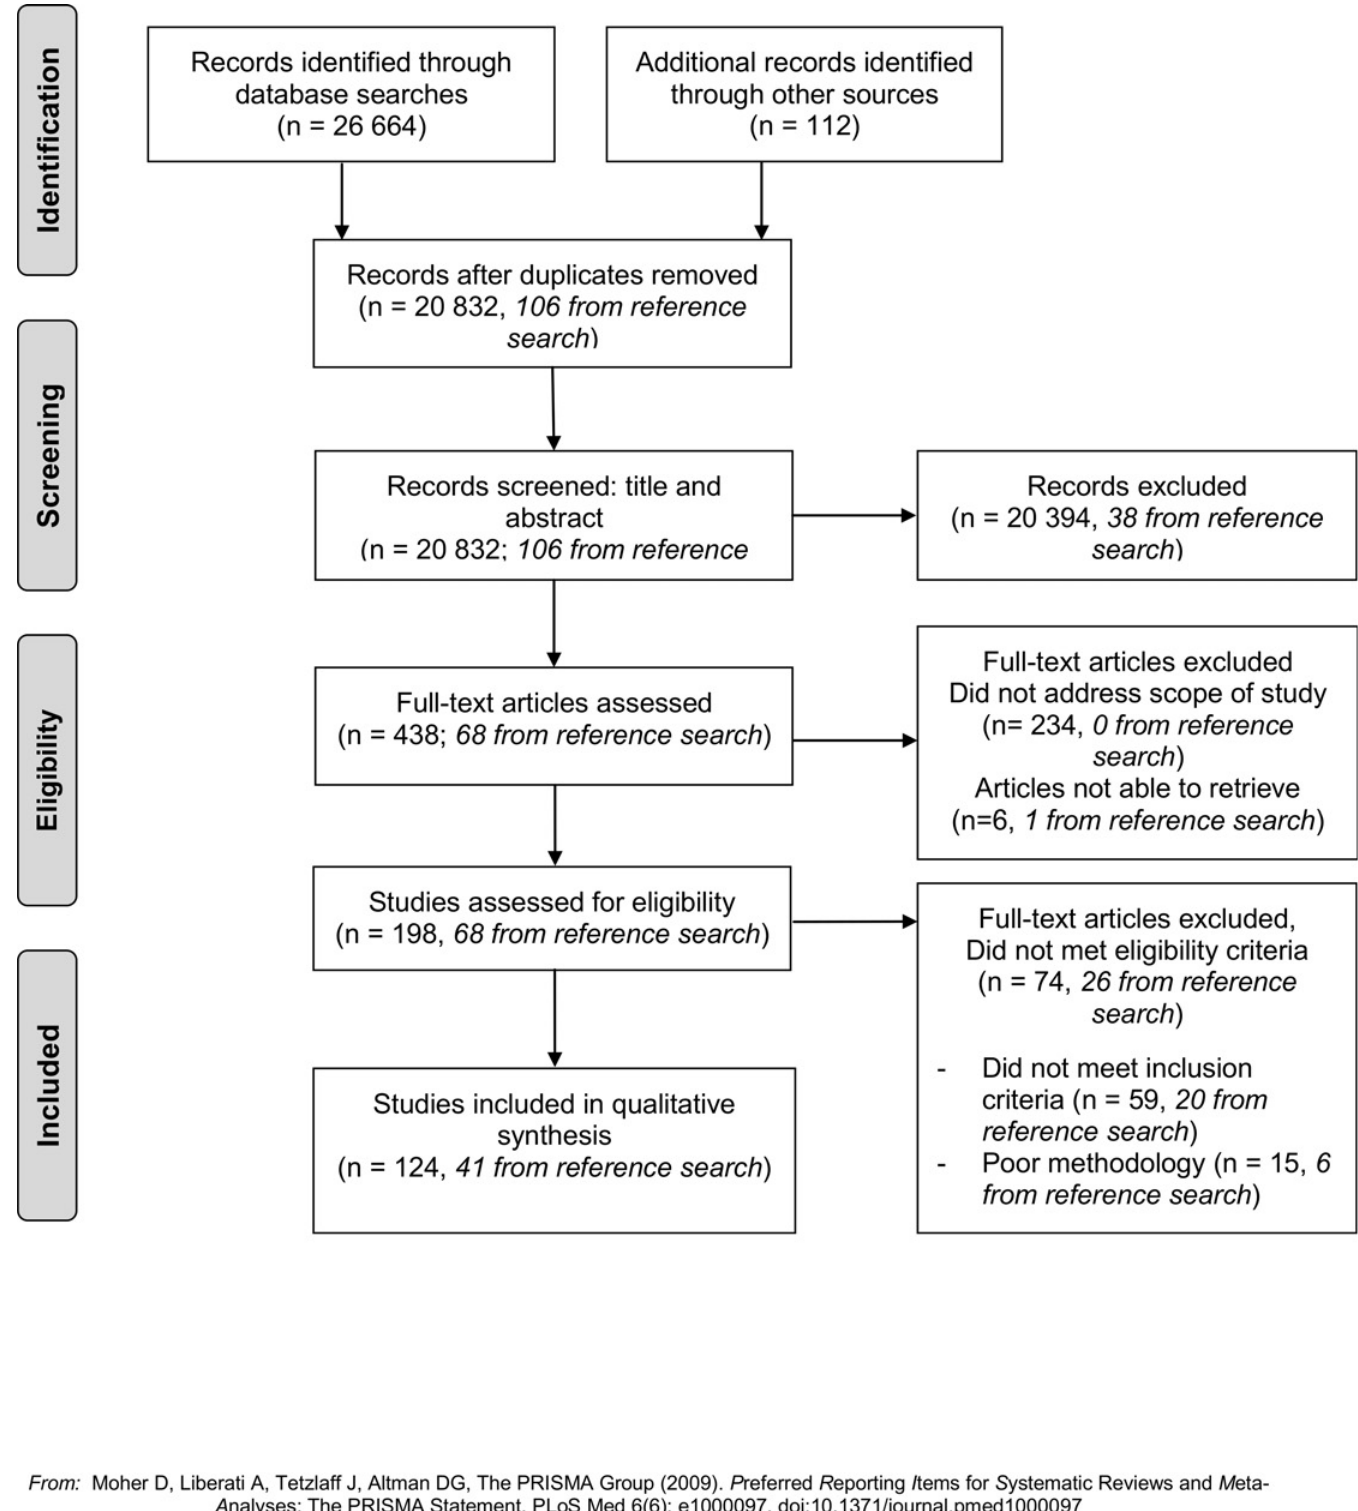
Fig 1. The Data Extraction Process. doi:10.1371/journal.pone.0150120.g001 PLOS ONE | DOI:10.1371/journal.pone.0150120 March 30,